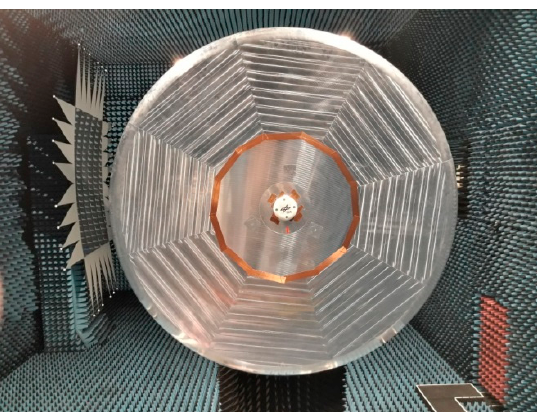
Figure 4. Top left : manufactured DLR array (on the top left ) compared with a commercial avionic single antenna with the same 3.5-inch footprint; top right : antenna array placed on the small rolled edges ground plane during the electromagnetic measurement in the semi-anechoic near-field chamber at the DLR facilities; down : antenna array, placed on the big rolled edges ground plane, during the electromagnetic measurement in the Compact Test Range at the DLR facilities.